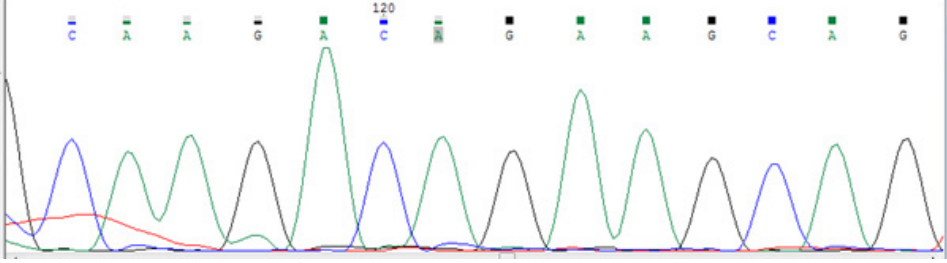
Figure 2. Electropherogram of R158Q mutation (CGG > CAG) in sample No. 8 (forward sequencing).